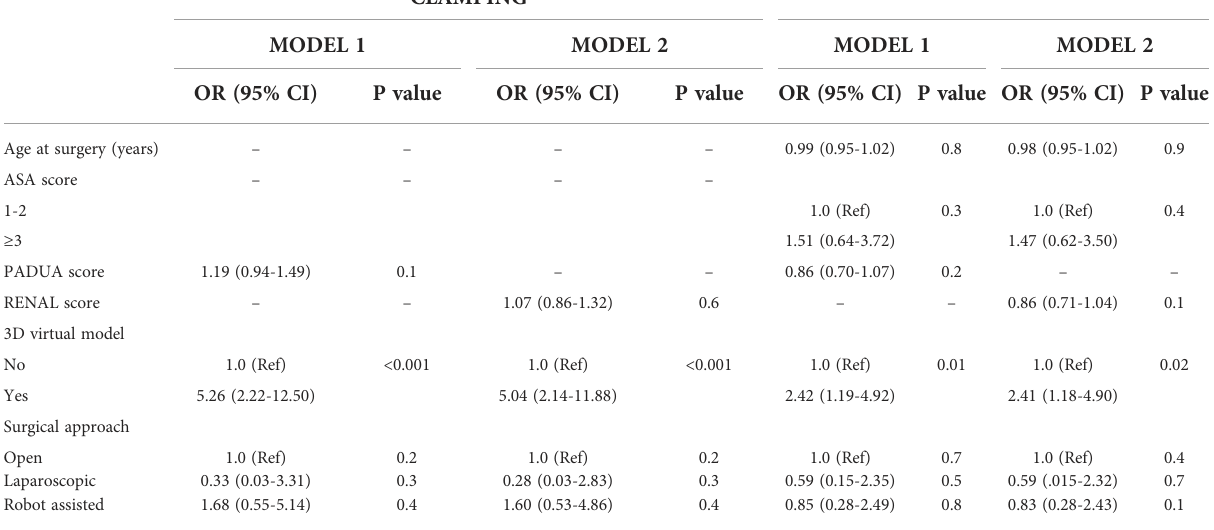
TABLE 5 Multivariate logistic regression analyses to predict the adoption of selective or super-selective clamping and the achievement of Trifecta in patients underwent PN (175), evaluating separately PADUA score (Model 1) and R.E.N.A.L. score (Model